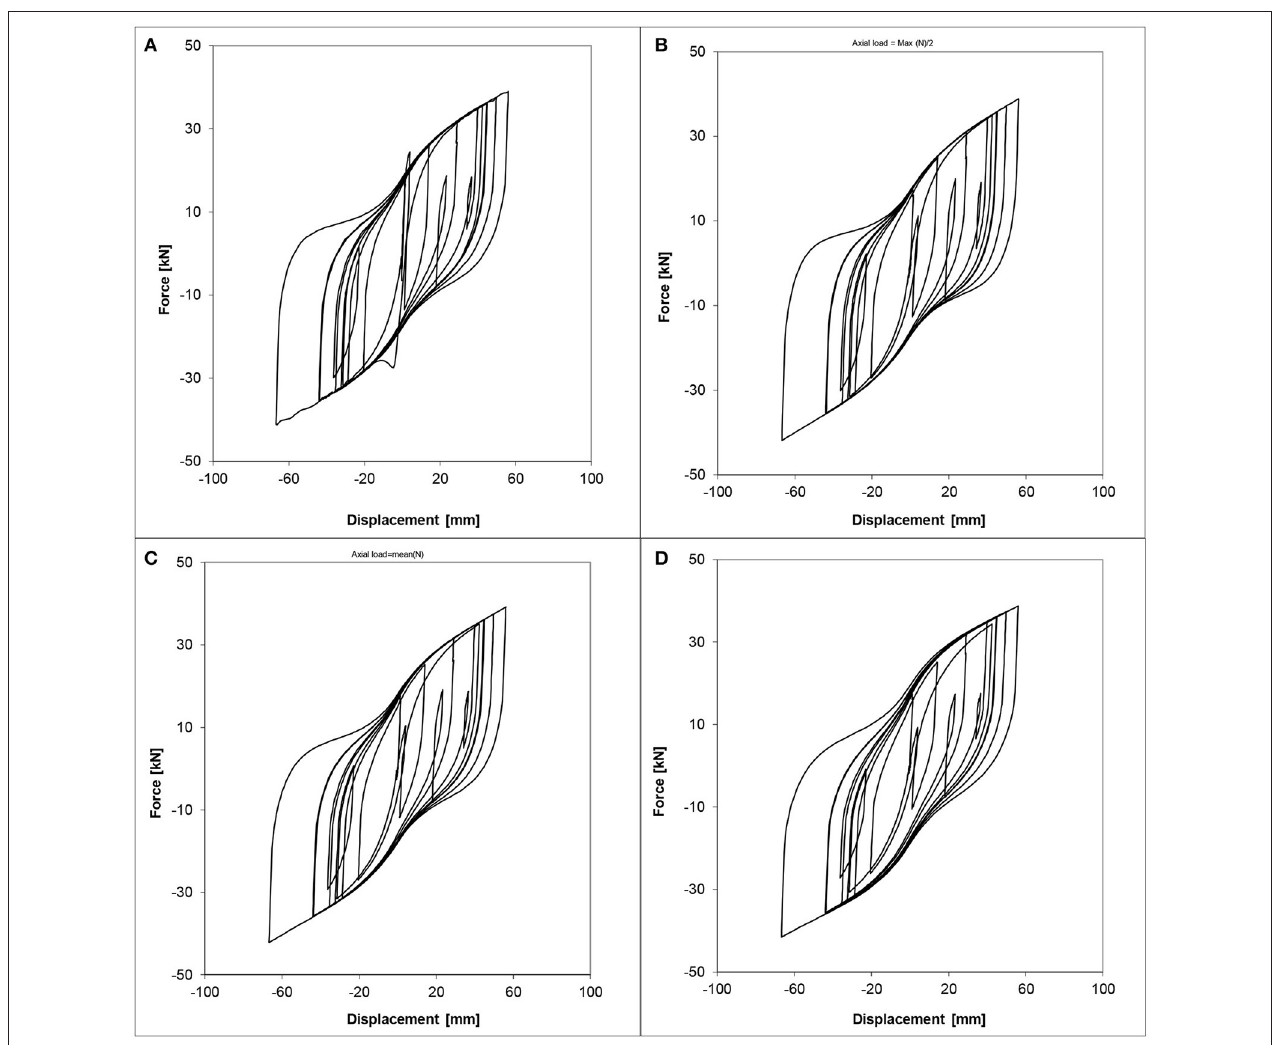
FIGURE 10 | Lead–rubber bearing shear force–displacement hysteresis loops for device #1 with: (A) varying vertical load, (B) 6.3 MPa constant vertical stress (half of the maximum value), (C) 8.4 MPa constant vertical stress (mean value), (D) 12.6 MPa constant vertical stress (maximum value).